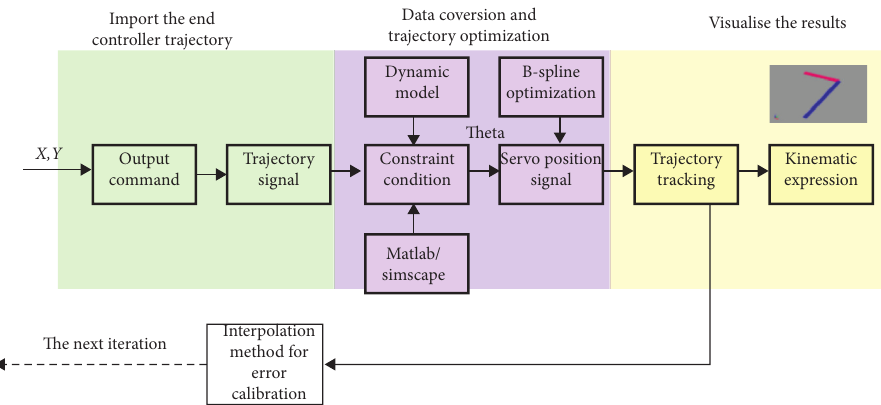
Figure 10: Repetitive control simulation process.